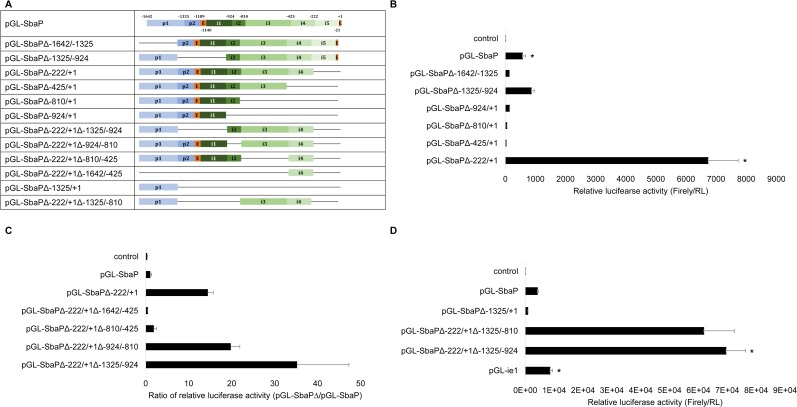
Characterization of regulatory region of 5’-flanking sequences of the shrimp β-actin gene based on the reporter assay.A: schematic diagram of series deletion constructs with luciferase reporter gene, which were made as described in Materials and Methods. Δ indicates a deletion; B-D: the relative levels of reporter gene expression in sf21 cells are shown. The constructs were transiently co-transfected into cells along with pRL-tk control vector. The activity of firely and Renilla luciferase in the cell lysate were measured using Dual-luciferase reporter assay (Promega) at 48h post transfection. Firefly luciferase activity was normalized to Renilla luciferase activity. The Bars indicated mean ±S.D. of luciferase activity (n = 3). *indicates statistical significance (P<0.01).